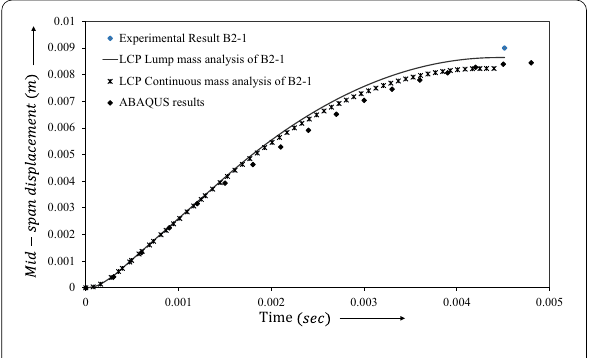
Fig. 29 Evolution of displacement for each case.